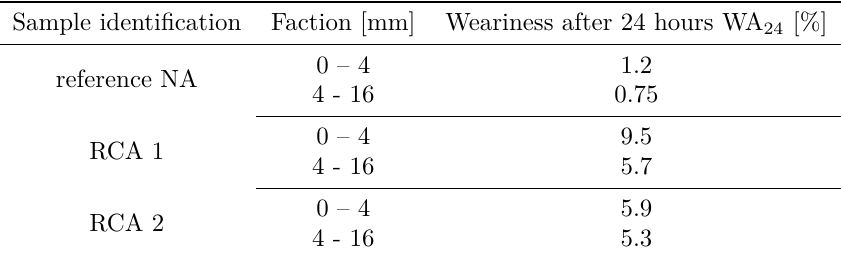
Table 4. Determination of 24 hours water absorption.